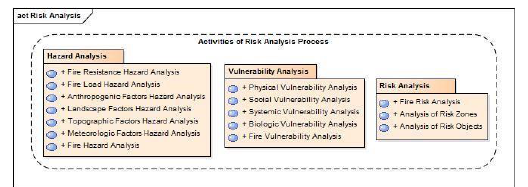
Figure 4: Activities of risk analysis process